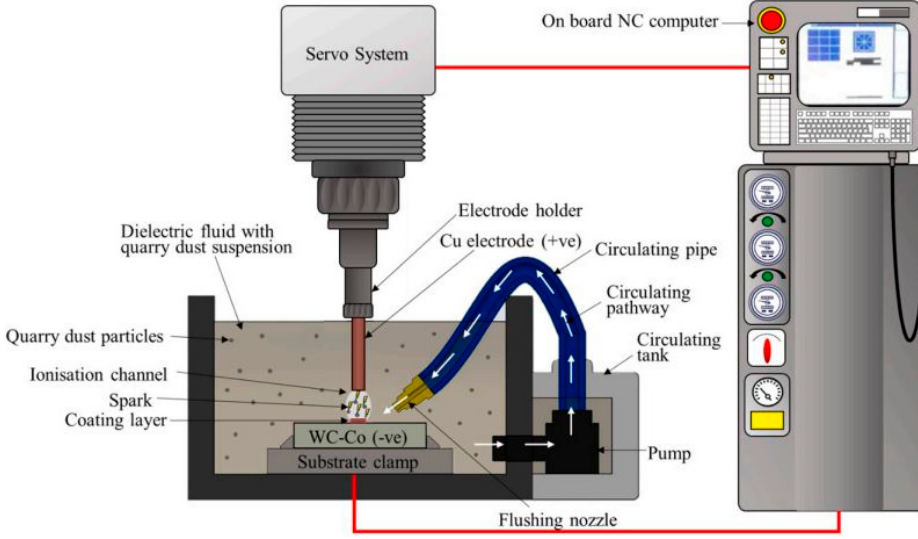
Figure 20. The EDC set-up for quarry dust suspension [163].